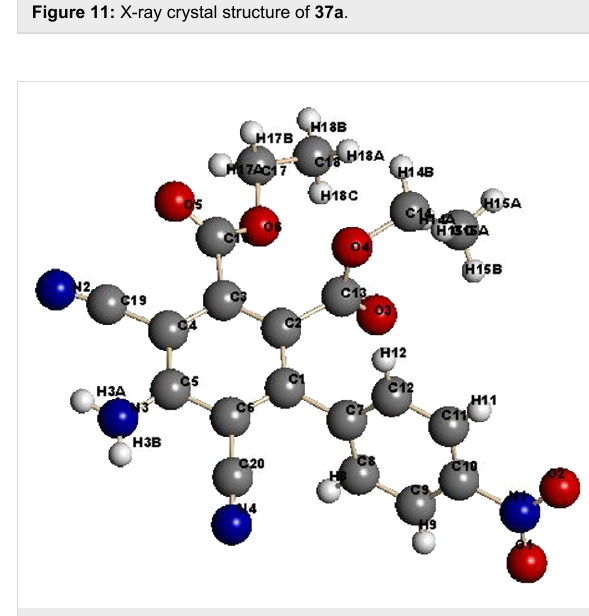
Figure 11: X-ray crystal structure of 37a .